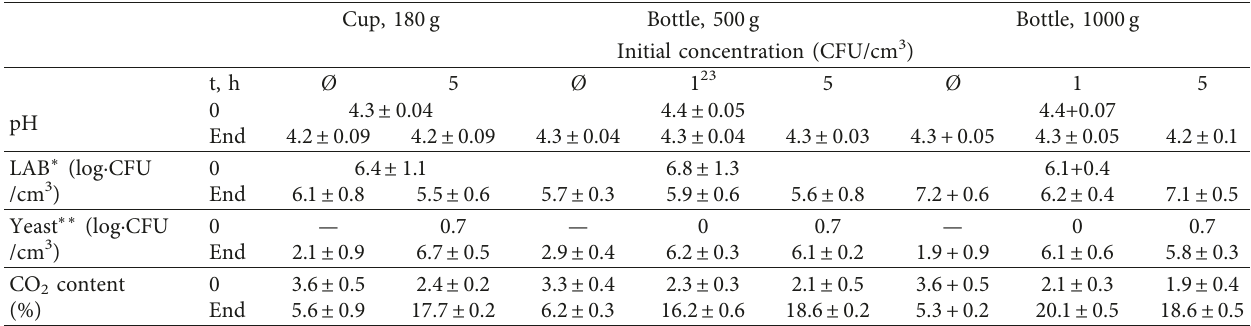
Table 1: Values ( SD) of pH, CO 2 content, and number of lactic acid bacteria (LAB) and yeast in yogurt not-contaminated ( Ø ) and contaminated with the yeast Candida kefyr (initial cell concentrations 1 and 5 CFU/cm 3 ), and packed in cups and bottles at the beginning (0) and the end of monitoring (end). ±